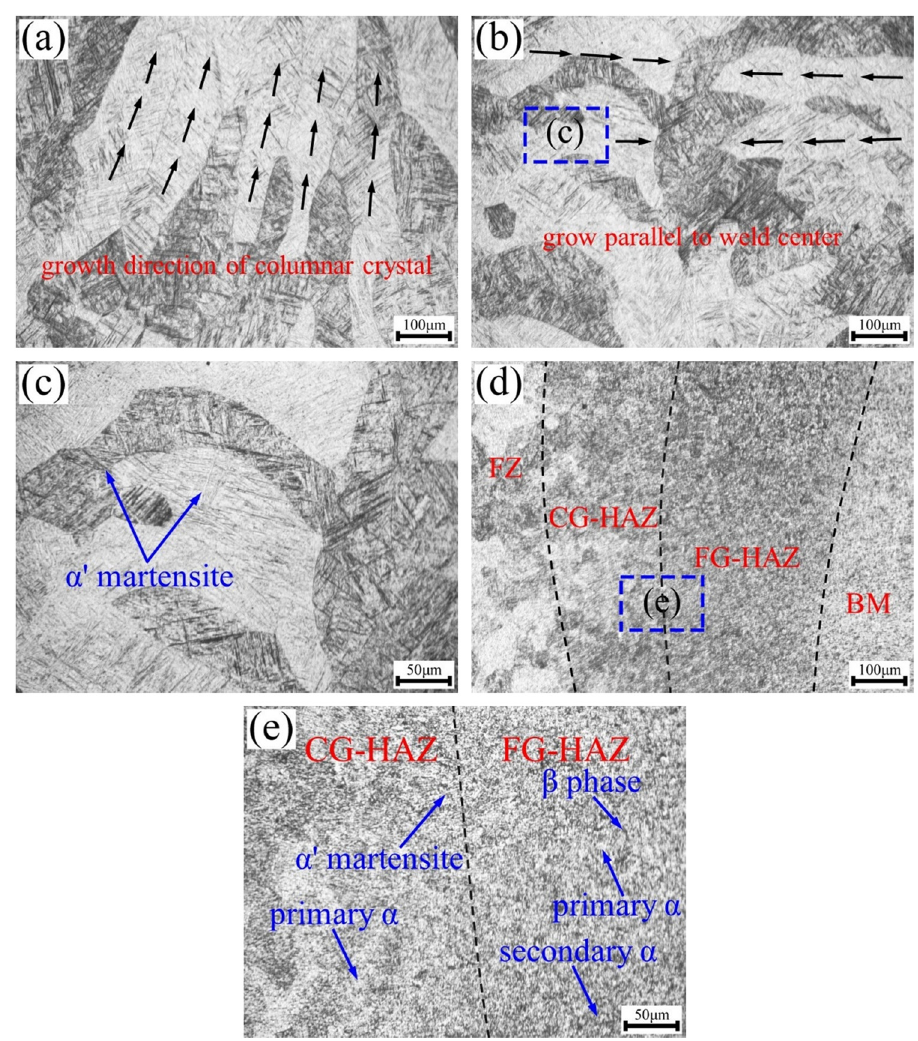
Figure 7: Microstructure of P - LBW joint: ( a ) the upper part of FZ, ( b ) the middle part of FZ, ( c ) magni fi cation of area c in ( b ) , ( d ) HAZ, and ( e ) magni fi cation of area e in ( d )